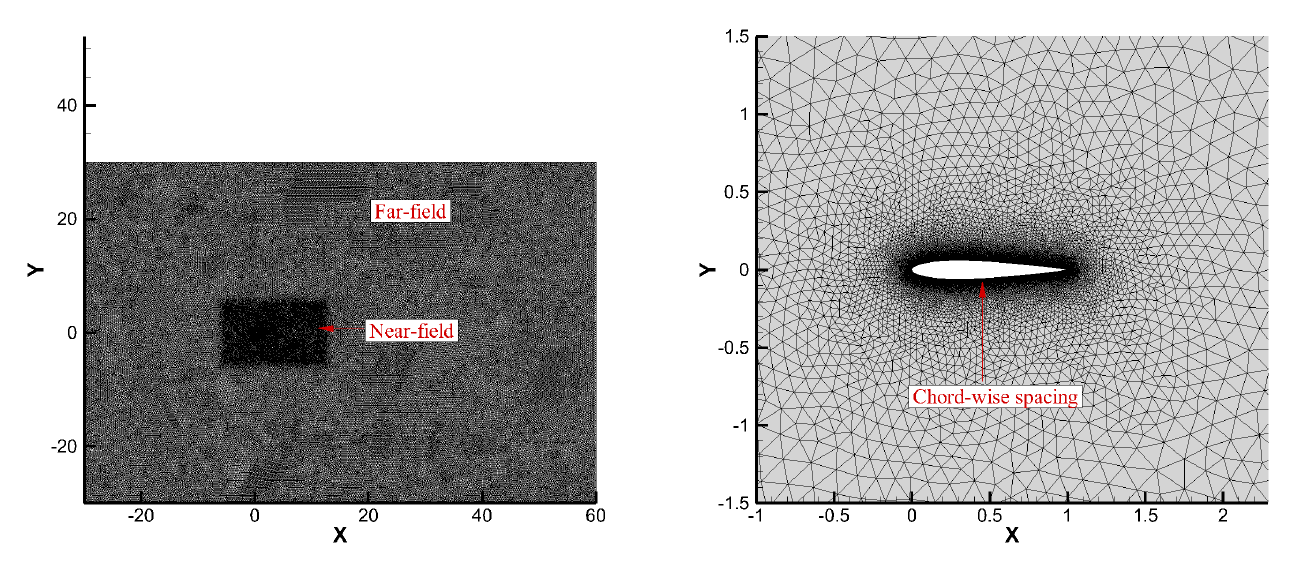
Figure 16. Node distributions for